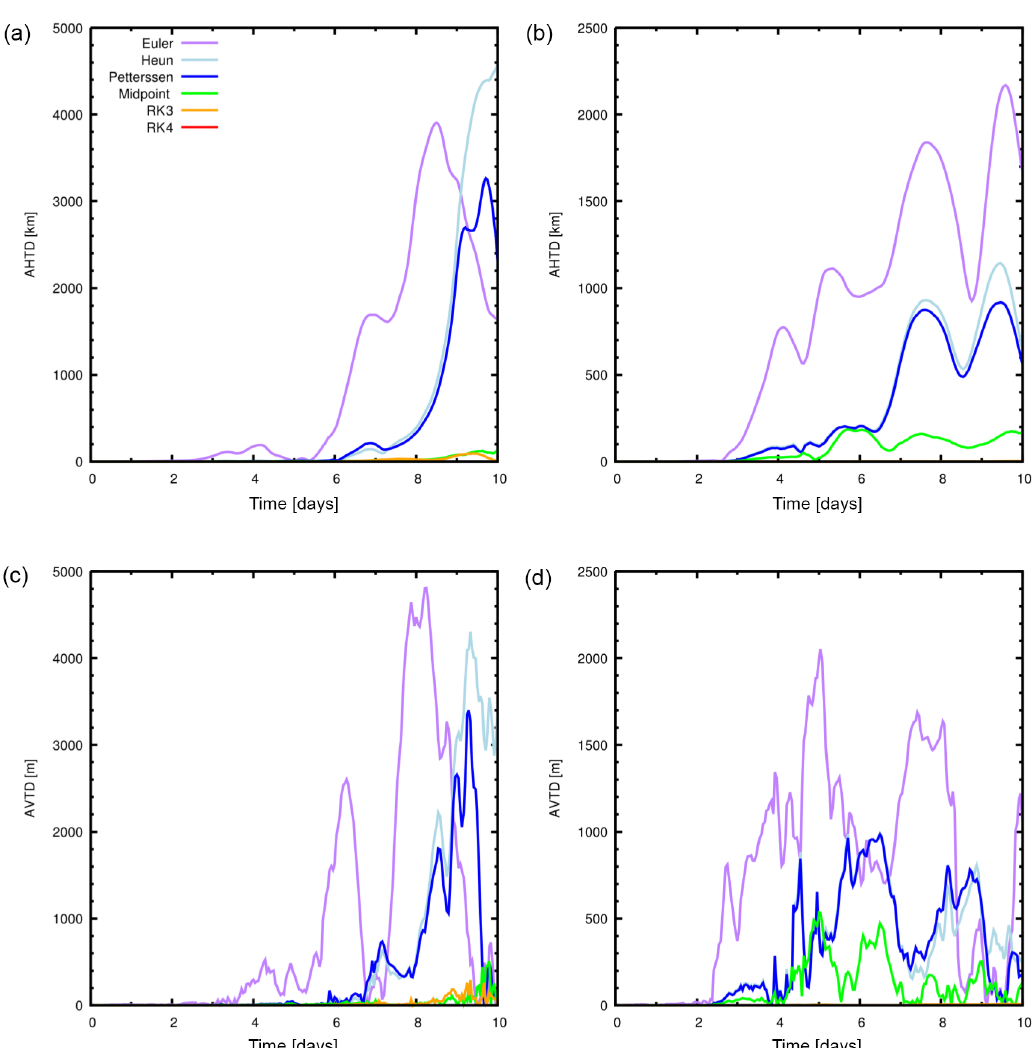
Figure 3. Absolute horizontal (a, b) and vertical (c, d) transport deviations for the case studies for the Northern Hemisphere (a, c) and Southern Hemisphere (b, d) presented in Fig. 2. Please note the different ranges of the y axes. Results of the RK3 and RK4 methods are close to zero in most